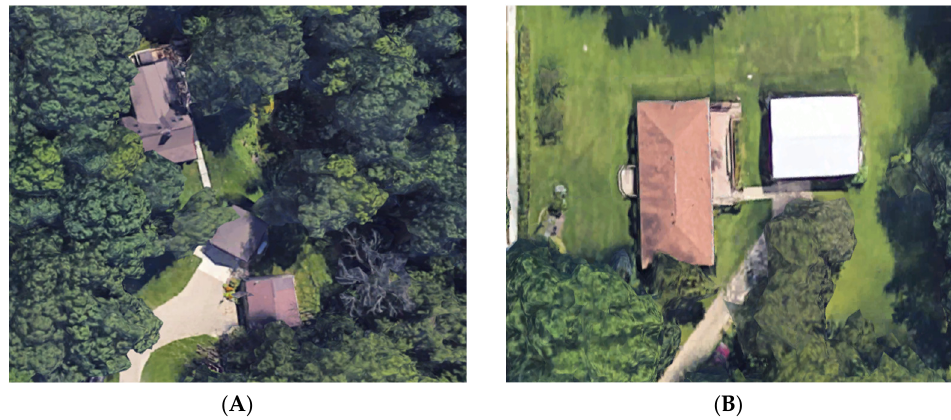
Figure 4. Image classifications for deep learning model (( A ) shaded vs. ( B ) unshaded). In Stage three, the proposed CNN model was trained to predict shaded and un- shaded houses. Figure 4A shows a shaded house where too many trees cover the sur- rounding of the house, reducing the amount of solar energy collected from PV installation.